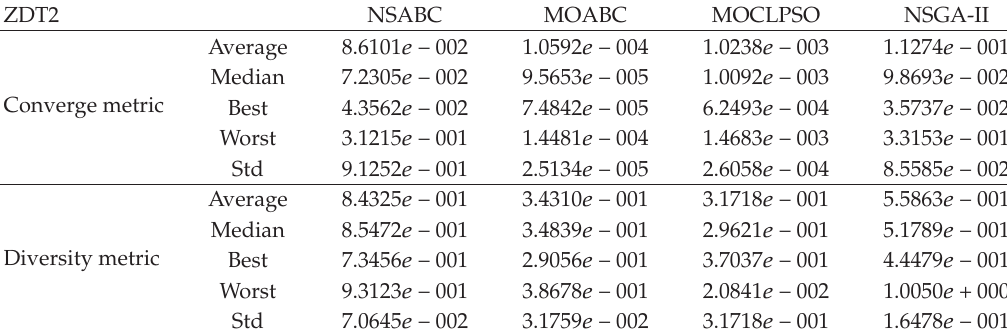
Table 8: Comparison of performance on ZDT2 after 20000 FEs.